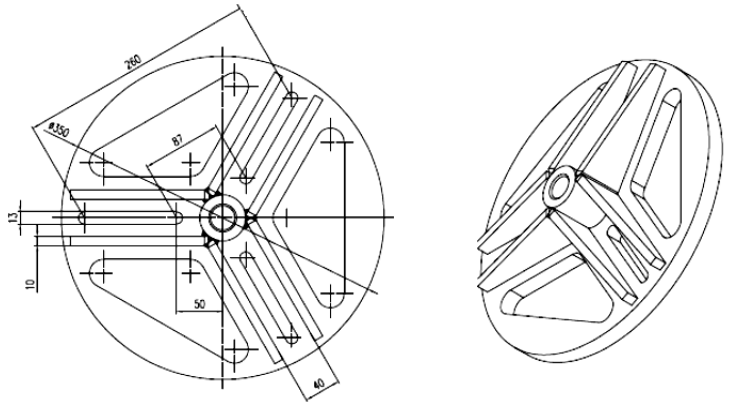
Figure 11. The schematic of the 3-anchor anchorage circle.